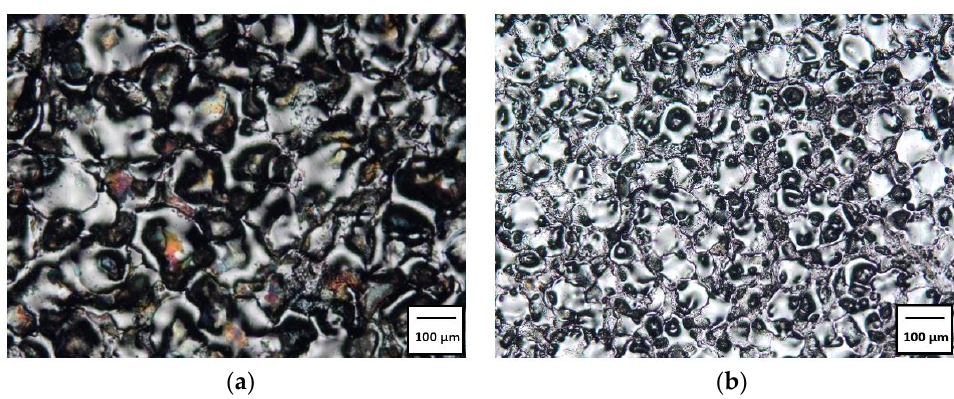
Figure 4. Surface texture of Hastelloy C-22 after EDM with S-180 ( a ) and AF-5 ( b ) graphite electrode for parameters: ( a ) I = 5 A, t on = 30 µs, t off = 37 µs; ( b ) I = 1.7 A, t on = 30 µs, t off = 37 µs.